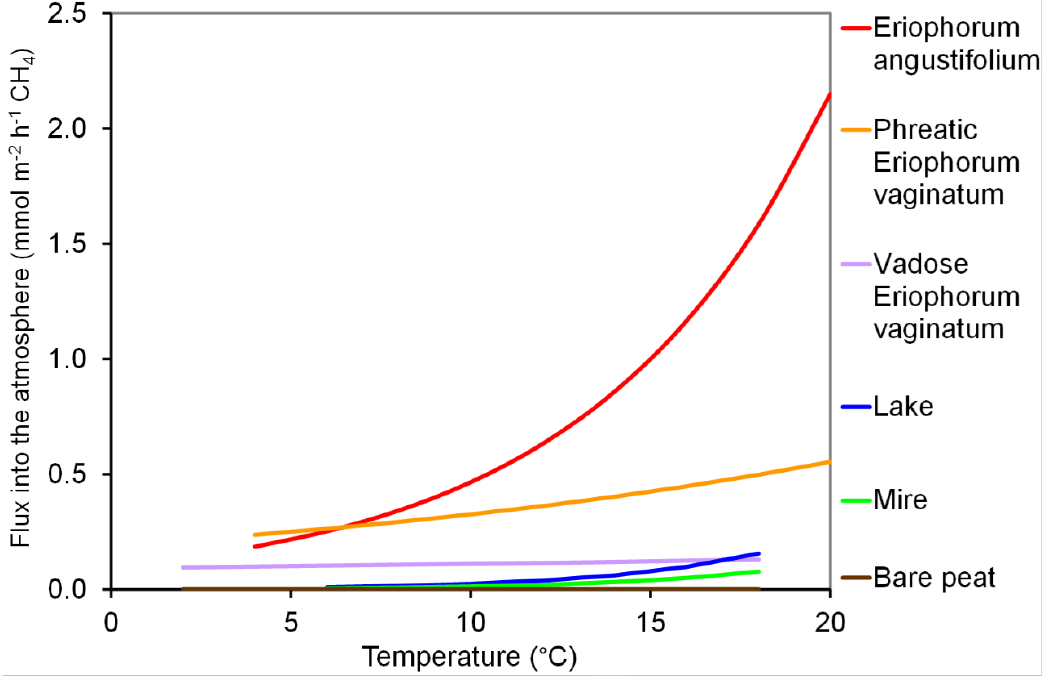
Figure 5. Ecotope CH 4 fluxes (mmol m -2 h -1 ) related to soil or water temperature (°C). Fluxes estimated with the linear mixed effects model (Table 6) based on measured temperature ranges. Table 8. Ecotope pairs with significantly different CH 4 fluxes to the atmosphere ( P ≤ 0.05), based on the linear mixed effects model. (Pairwise comparisons